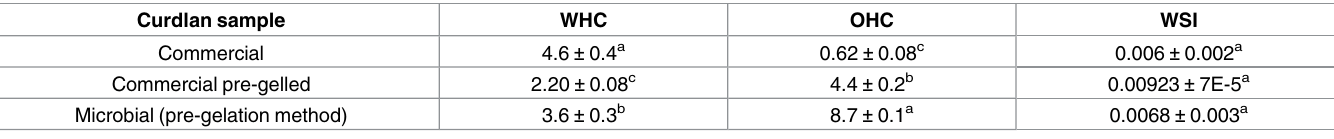
Table 3. Water Holding Capacity(WHC), Oil Holding Capacity(OHC) and Water Solubility Index (WSI) (g g -1 ) of the commercial, pre-gelled commer- cial curdlans and those produced by Agrobacterium sp. IFO 13140 (pre-gelation method). Valuesindicate mean ± standard-deviation. Curdlan